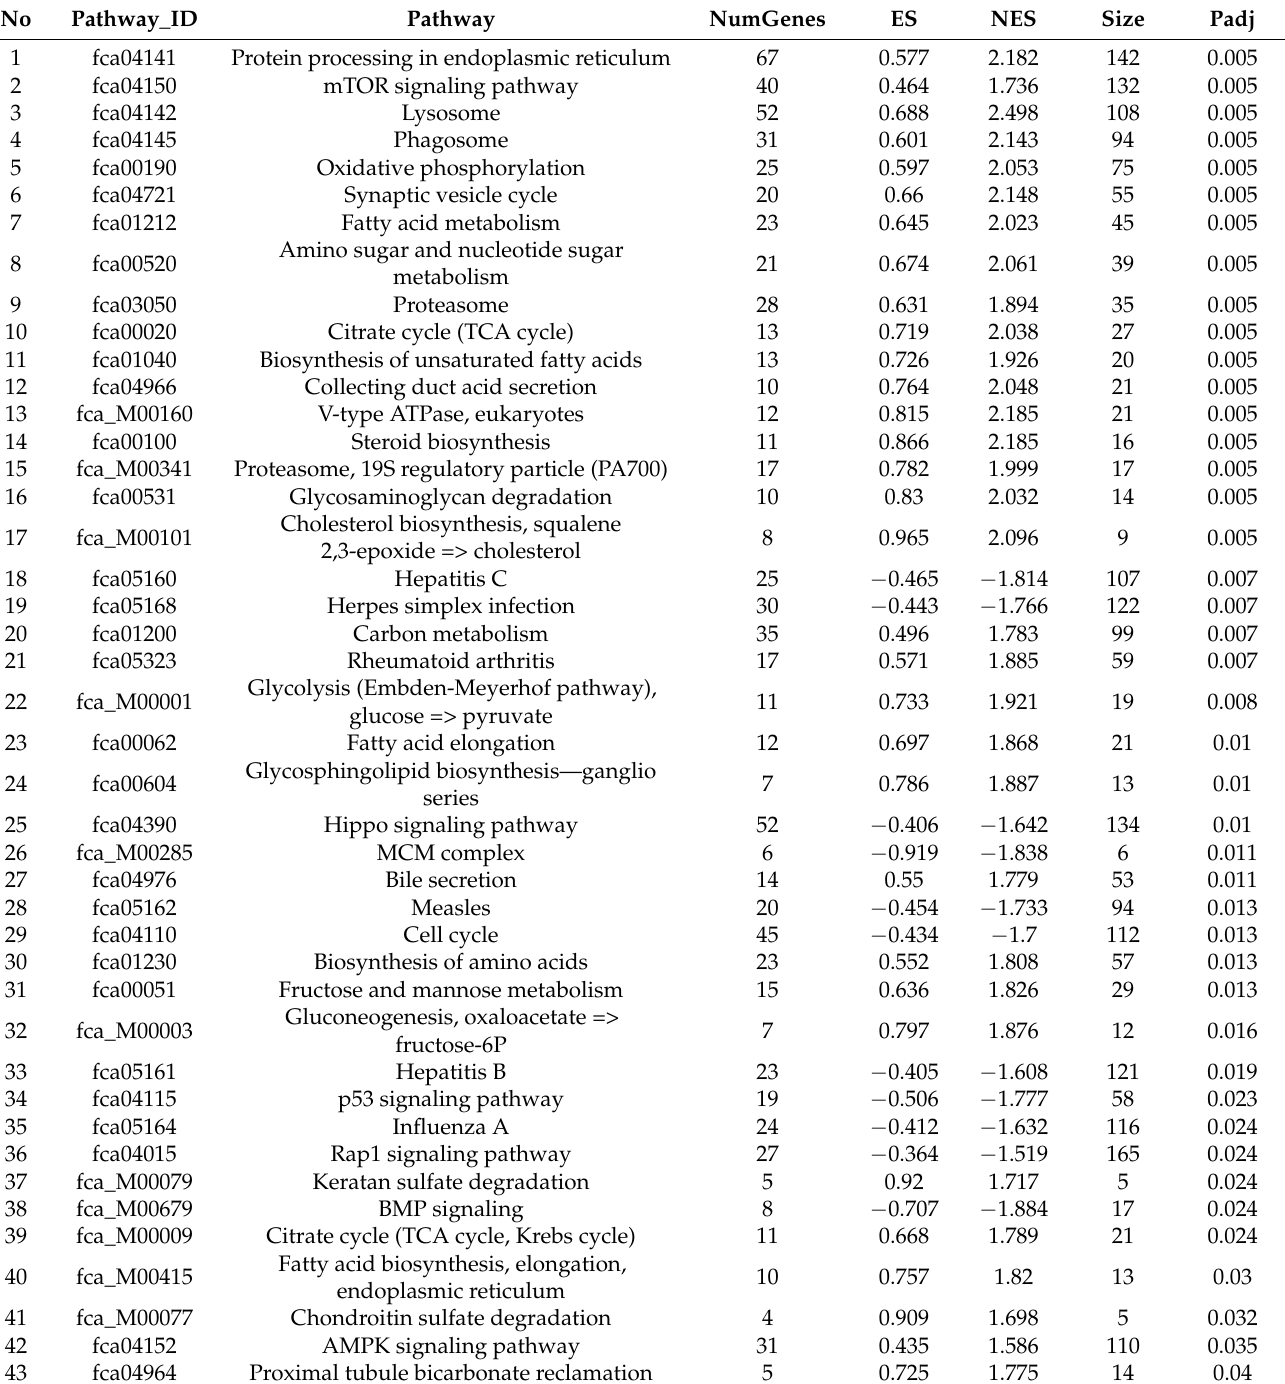
Table 6. Significantly enriched gene sets in CRFK cells sensitized with fADSC-CM compared with those in mock-treated CRFK cells using